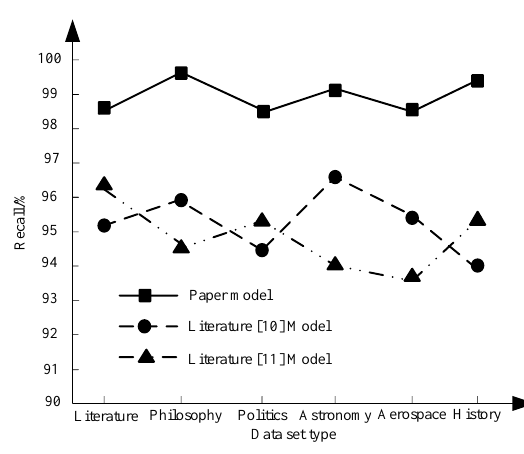
Fig.5. Comparison of recall rates of resource matching